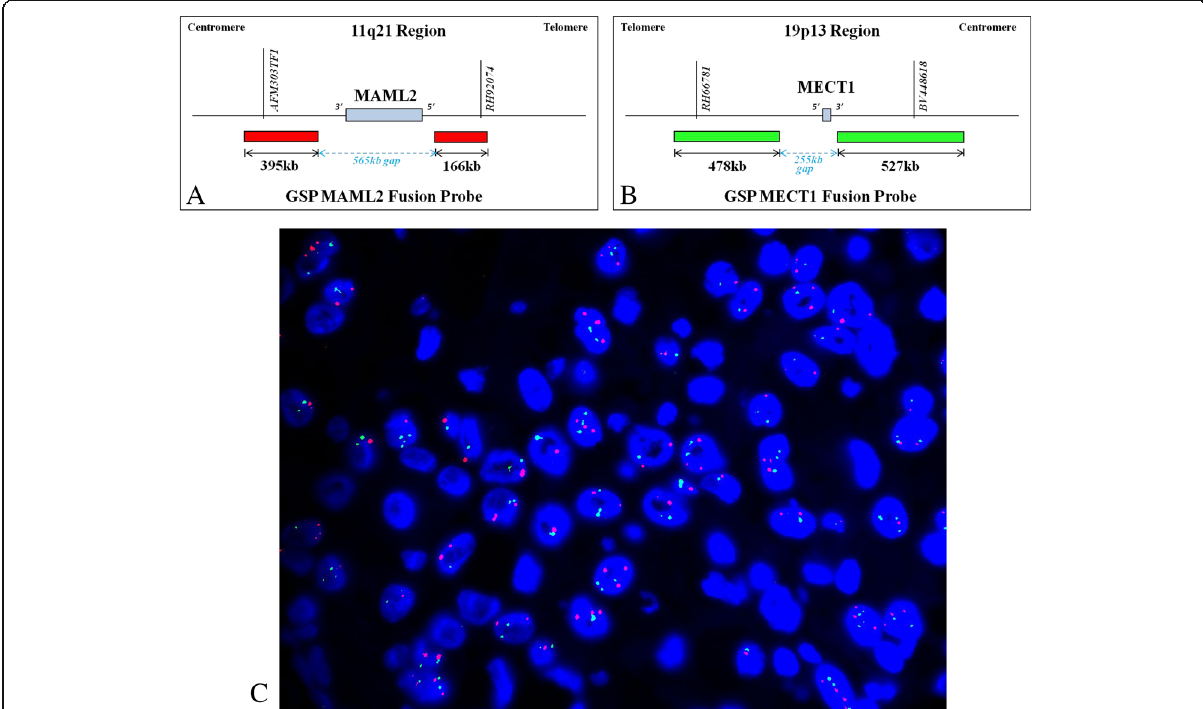
Fig. 4 FISH analysis for the CRTC1/MECT1-MAML2 fusion gene. Probe pattern diagram: GSP CRTC1/MECT1 green fusion probe, GSP MAML2 red fusion probe (top). Non-typical positive signal mode, CRTC1/MECT1-MAML2 fusion gene was negative